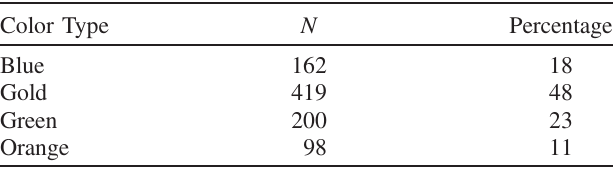
TABLE V. Dominant color types.